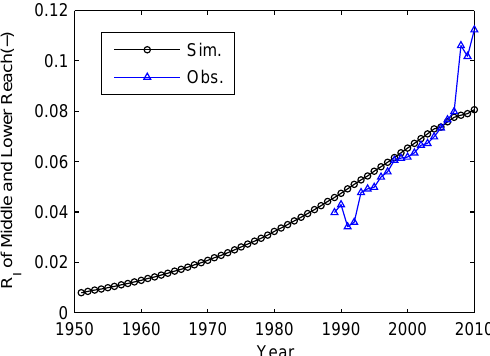
Figure 11. Population of the lower reach of the Tarim